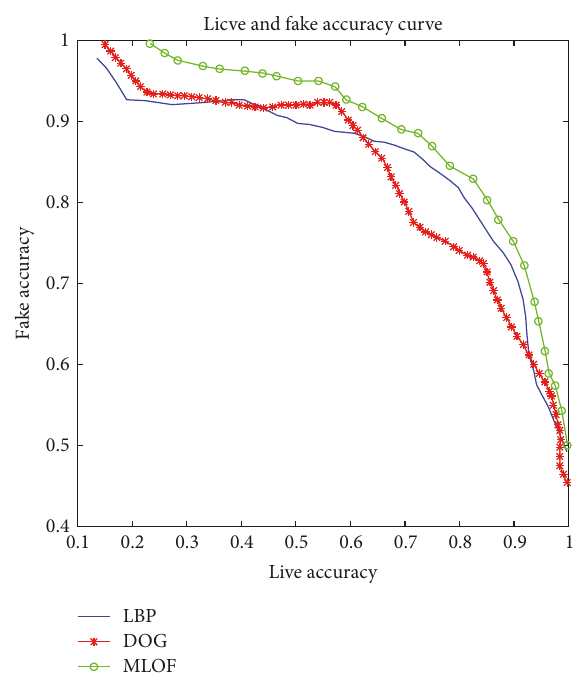
Figure 11: The accuracy curve of different methods.